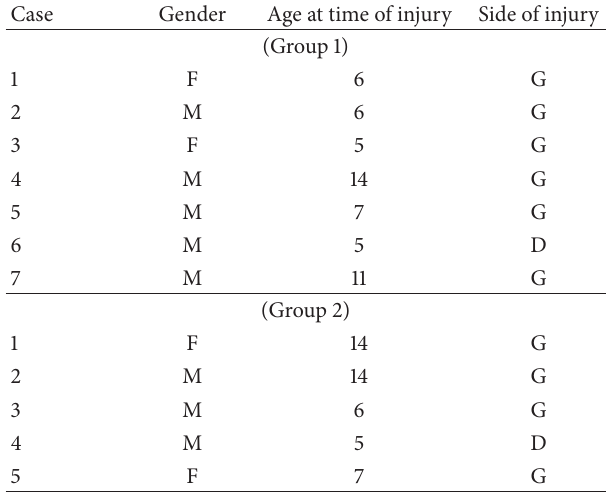
Table 1: Patient characteristics: Age, gender, and side of